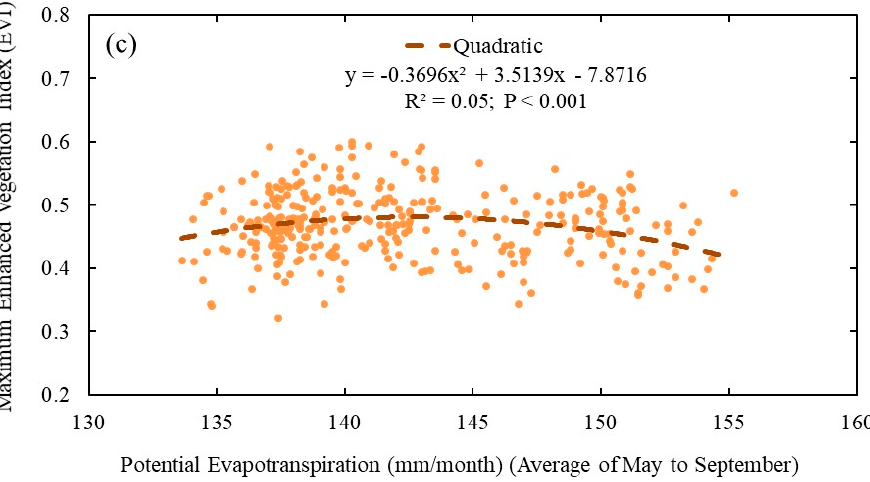
Figure 7. Potential evapotranspiration (PET) of 26 wild blueberry fields and its relationships with temperatures and enhanced vegetation index. ( a ) Historical comparison in average potential evapotranspiration (PET) between 1970–2000 and 2001–2014 periods from January to December. The data are represented as the means ± standard errors (n = 26; where 26 represents the number of wild blueberry fields). Differences are significant at p < 0.001 ***; p < 0.01 **; p < 0.05 *. ( b ) The relationship between maximum temperature (average of May–September) and potential evapotranspiration (average of May–September) from 2000 to 2014. The observed data points (n = 26*15 = 390) are from the 26 wild blueberry fields in Downeast Maine over 15 years (2000–2014). The dashed line in ( b ) is a linear relationship fitted to the data with multiple linear regression ( p < 0.001). ( b ) The relationship between potential evapotranspiration (average of May–September) and Maximum Enhanced Veg- etation Index (EVI max ) of the 26 wild blueberry fields in Downeast Maine from 2001 to 2014. The observed data points (n = 26 × 14 = 364) are from the 26 wild blueberry fields for 14 years (2001–2014). The dashed line in ( c ) is a quadratic relationship fitted to the data with multiple linear regression ( p <